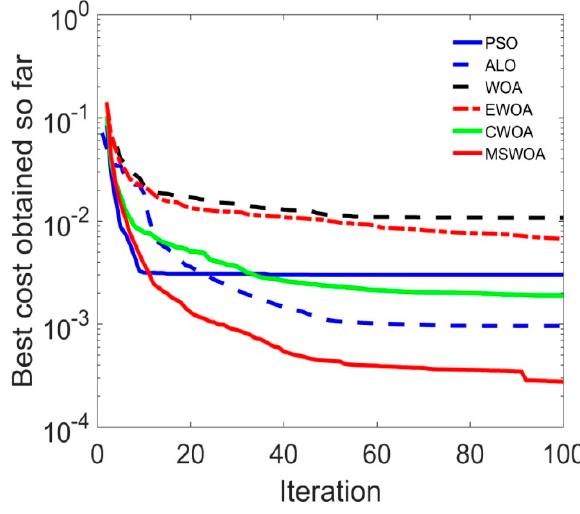
Figure 10. Comparison of average iteration process under load conditions.